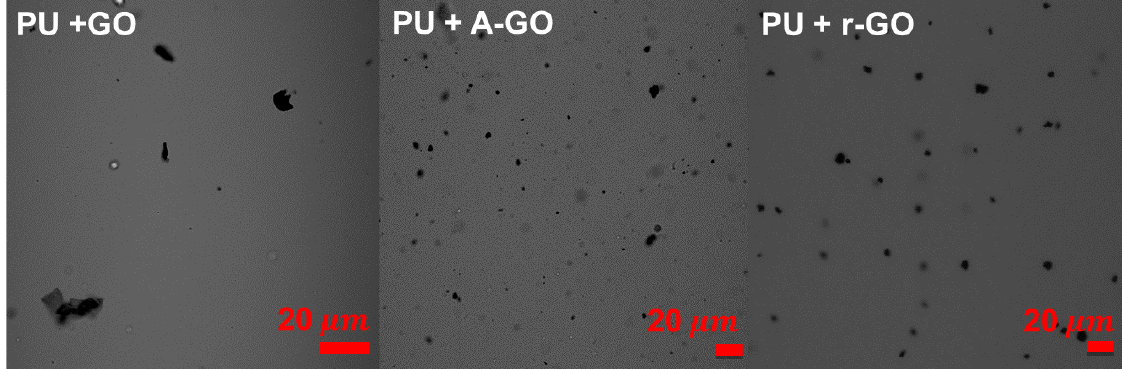
Figure 16. Stress-strain curves of the PUs.